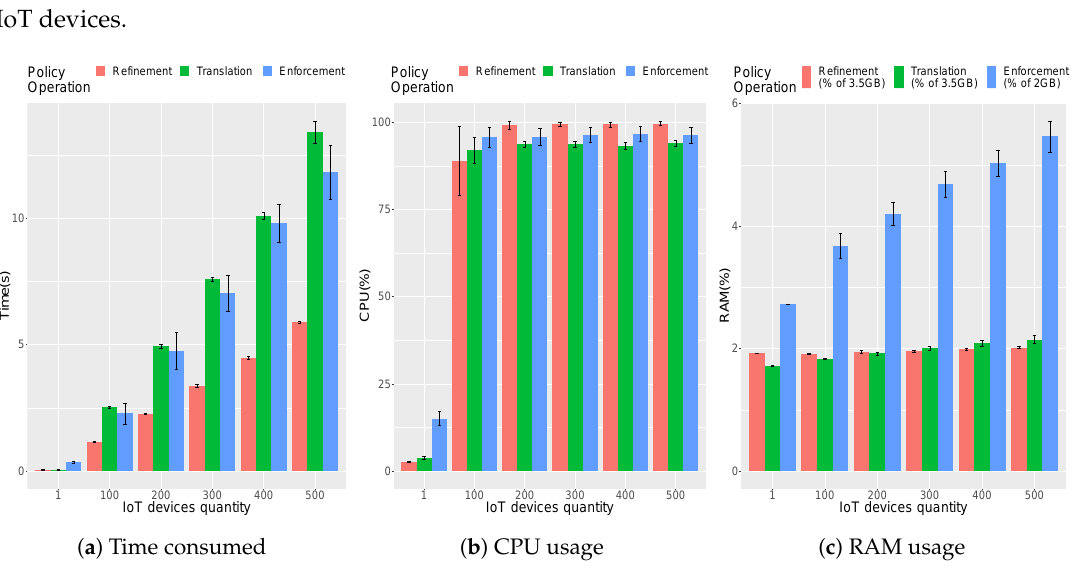
Figure 9. Scalability